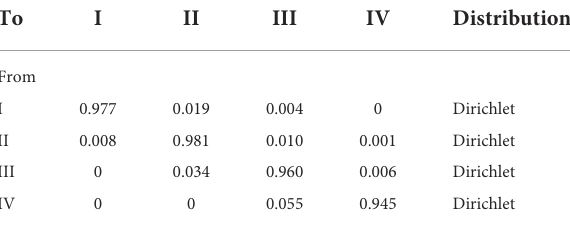
TABLE 2 New York heart association classes transition probabilities per cycle (3